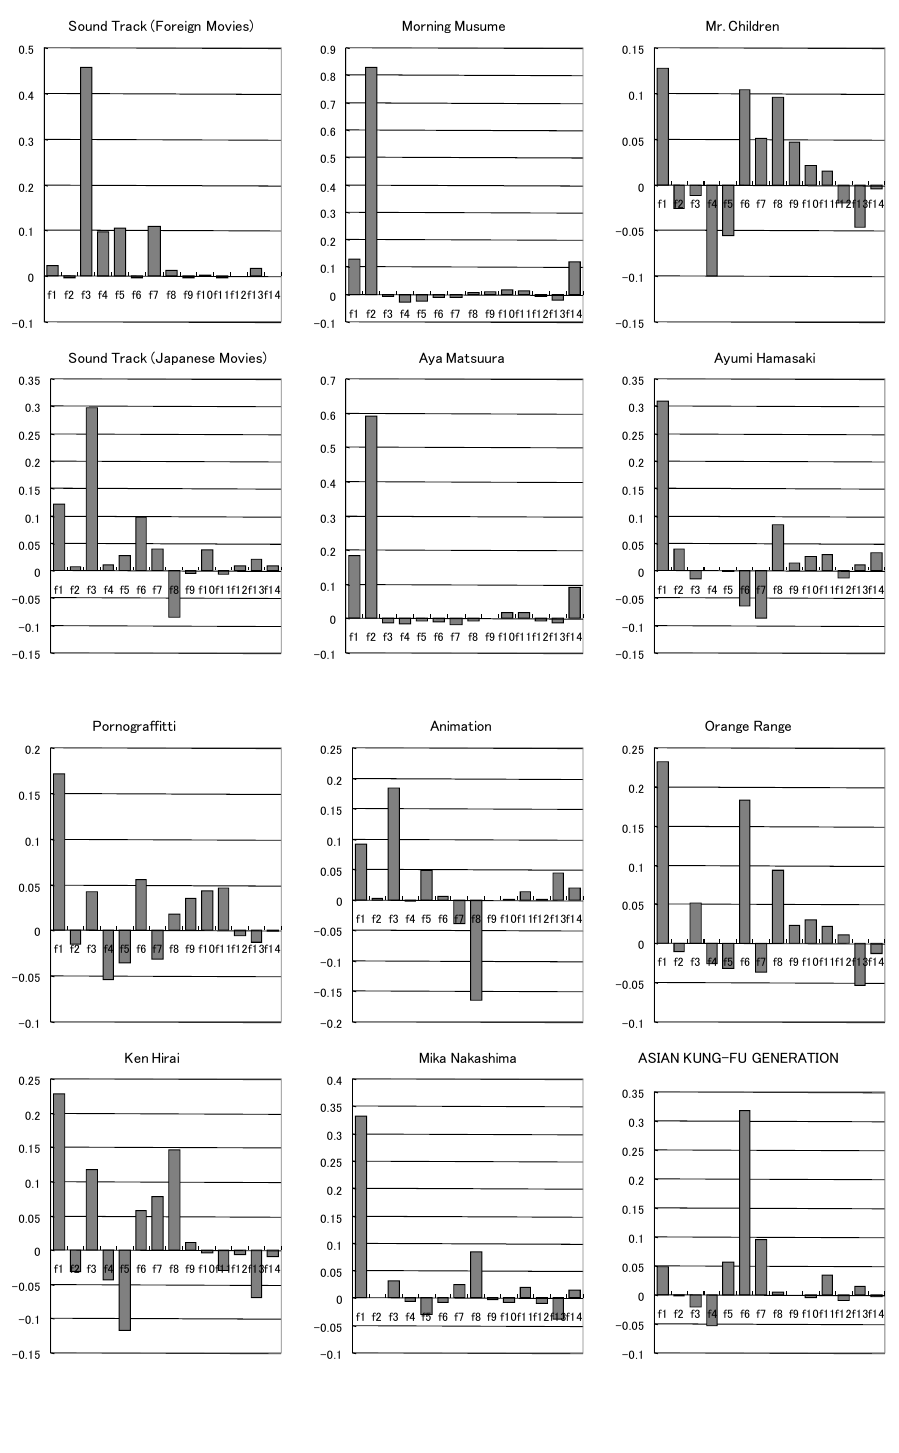
Figure 1. Attributes of representative